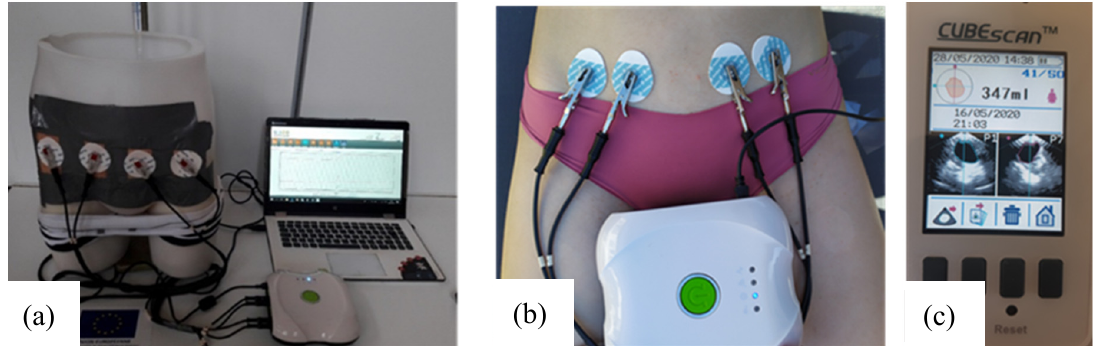
Figure 5. ( a ) The whole test bench including the pelvic phantom, the measuring device and a computer; ( b ) tetrapolar bioimpedance measurements realized on individual 2; ( c ) bladder volume before voiding recorded by the bladder scan (screenshot).